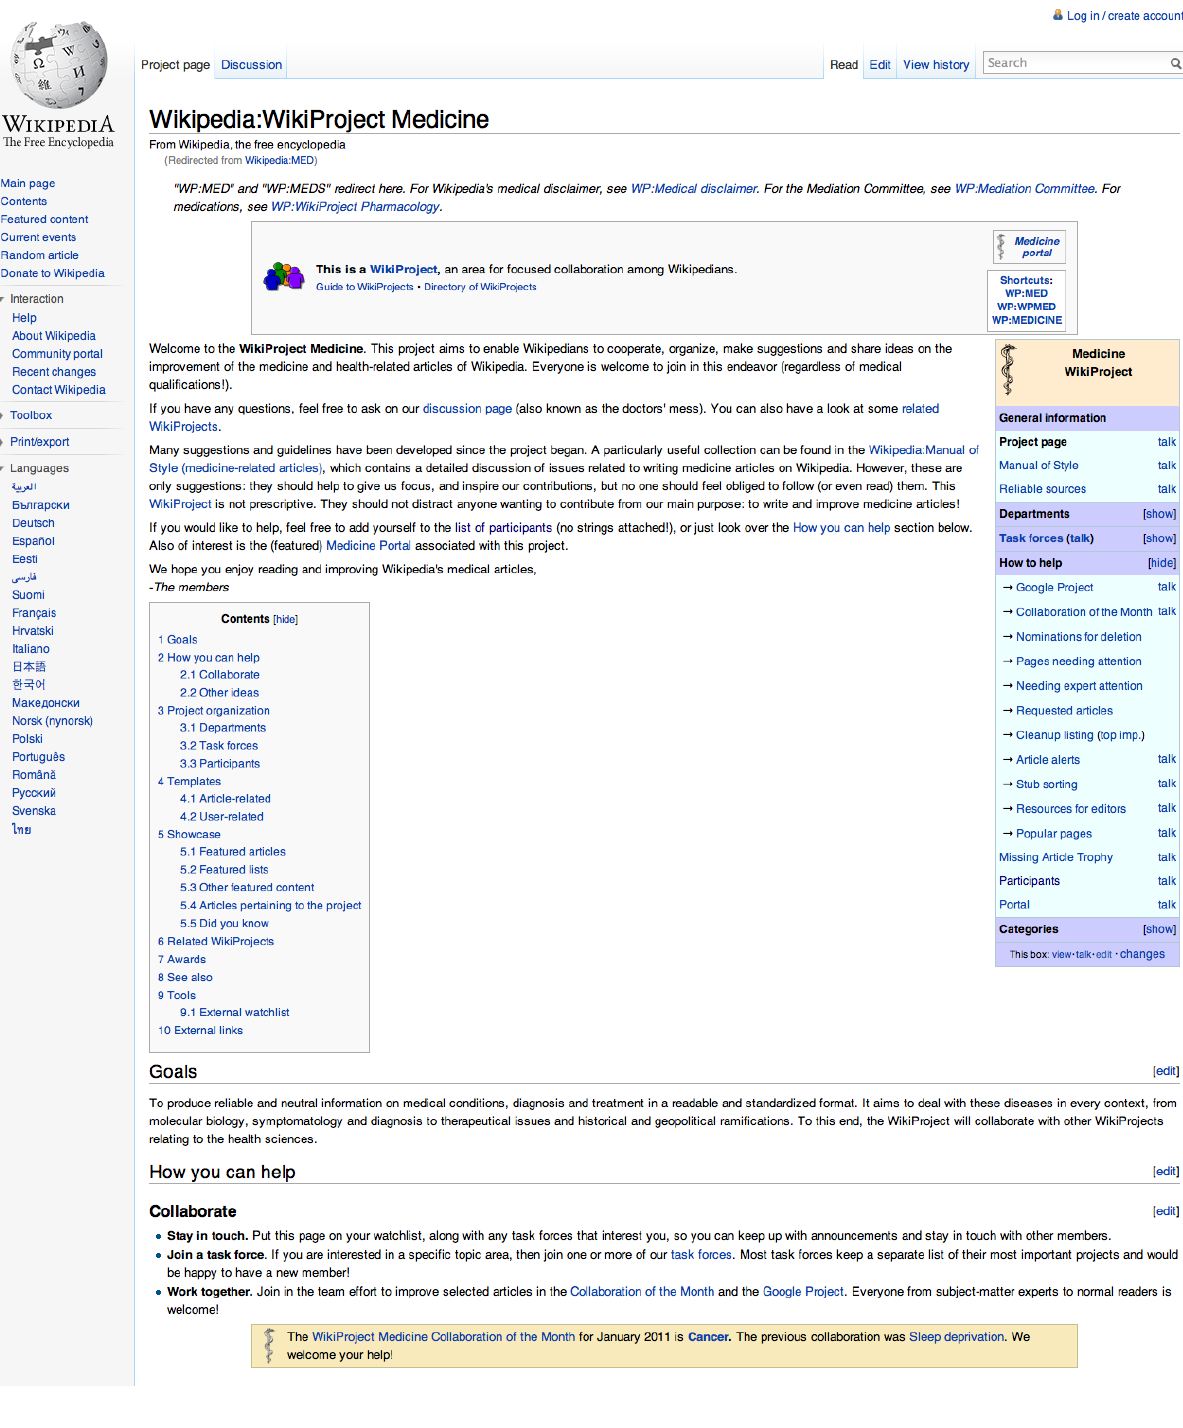
Figure 1. WikiProject Medicine. URL: